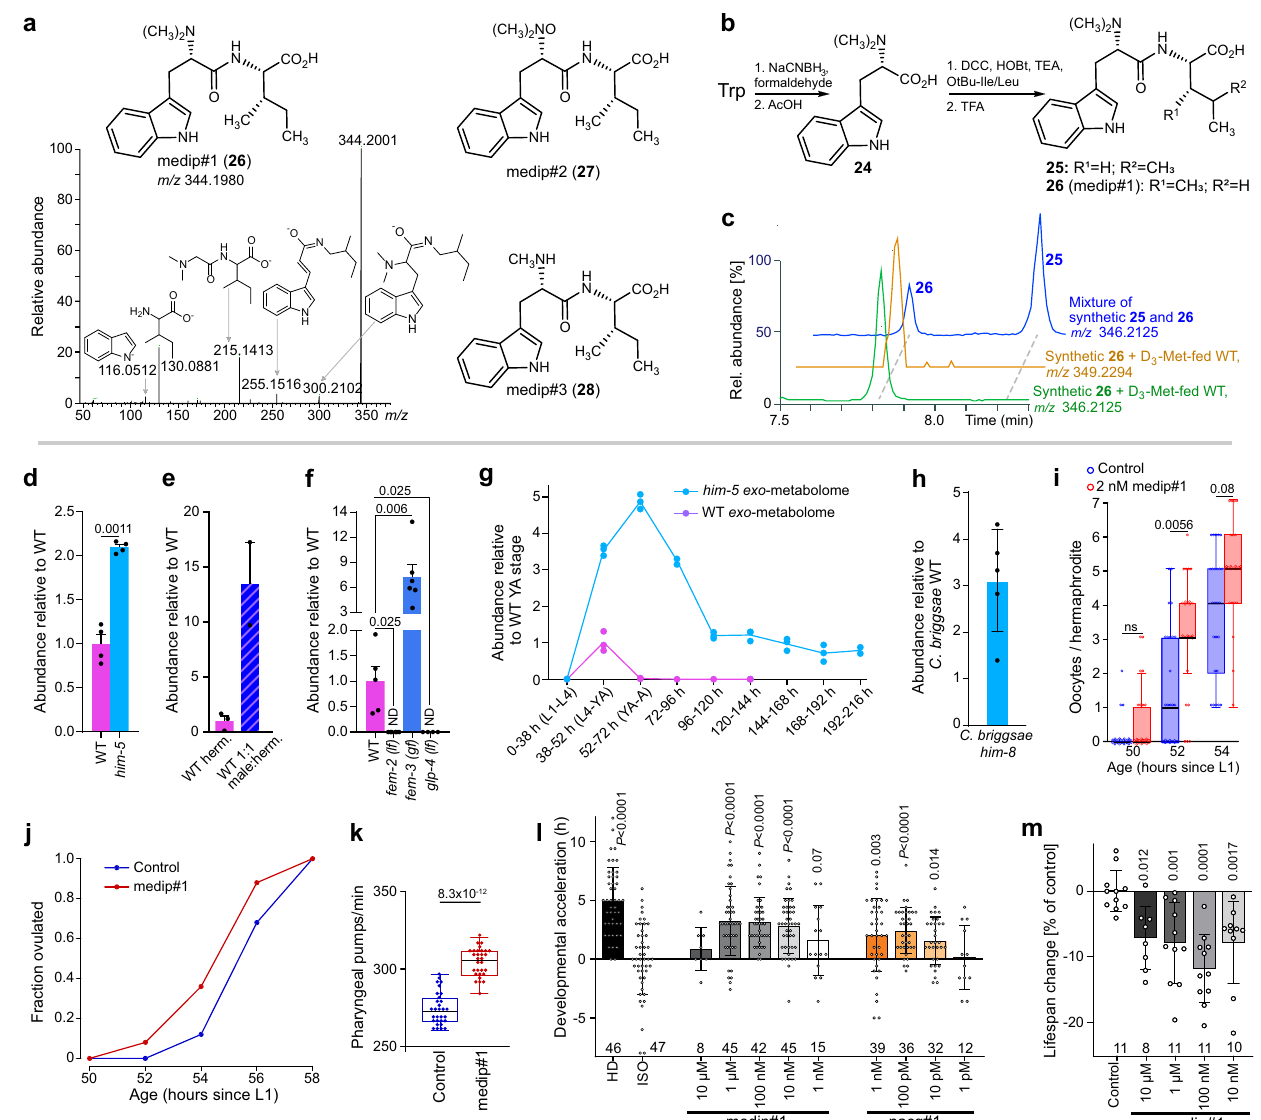
Fig. 4 | Identi fi cation, germline dependence, and biological activity of dipep- tide medip#1. a Chemical structures of medip#1 – 3 ( 26 – 28 ) and MS2 fragmenta- tion of medip#1 ( 26 ) in ESI- mode. b Synthesis of medip#1 and related molecules. c Ion chromatograms for m/z 346.2125 and 349.2294, corresponding to medip#1 and D 3 -medip#1, from exo -metabolome extracts of him-5 animals supplemented with D 3 -Met and a synthetic sample containing medip#1 ( 26 ) and its Leu-derived isomer ( 25 ). d , f Abundance of medip#1 in exo- metabolome extracts of ( d ) him-5 relative to WT, e 1:1 male:hermaphrodite mixtures relative to WT hermaphrodites, and f indicated germline mutants relative to WT. Data represent four ( d ), two ( e ), and four or six ( f ) biologically independent experiments, and error bars represent mean±s.e.m. P valueswerecalculatedbytwo-sidedWelch t tests;ND,notdetected. g Developmental stage-dependent production of medip#1 in WT (purple) and him-5 (light blue) animals. Data are from three independent biological replicates, except for two independent biological replicates for day 7. h Abundance of medip#1 in the exo -metabolome of male-enriched C. briggsae him-8 mutants rela- tive to WT C. briggsae . Data represent fi ve biologically independent experiments. i Fasteracquisitionofoocytesinhermaphroditesexposedto2nMofmedip#1(red) compared to paired controls (blue). Boxes represent the two inner quartiles, hor- izontal lines represent medians, and whiskers extend to 1.5× of the box data. Data represent one experiment with n =25 animals for each condition; P values were calculated by Kolmogorov – Smirnov test. j Hermaphrodites exposed to 2nM of